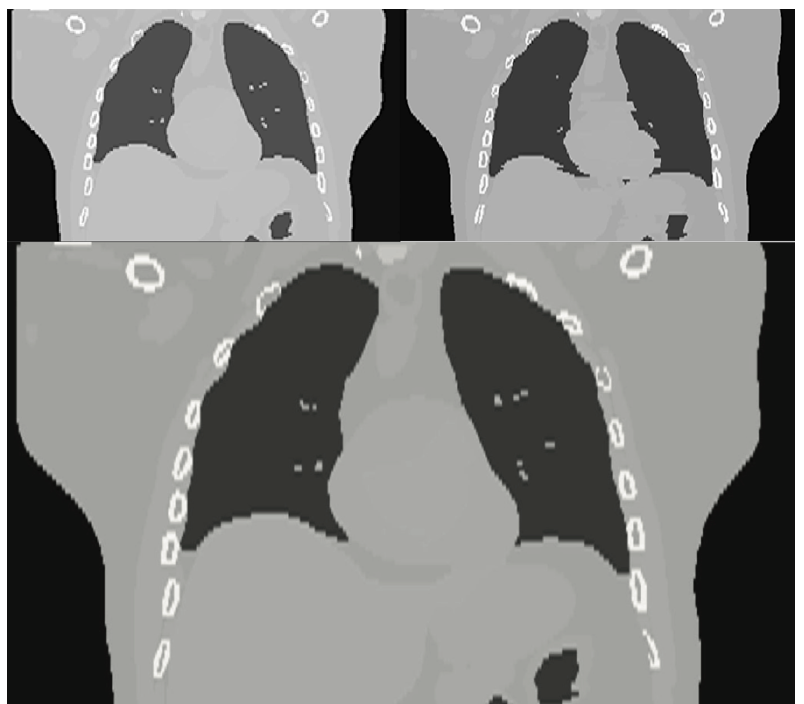
Figure 5. The XCAT phantom images based experiment results. The upper row: two CT scans with simulated motion artefacts. The bottom row shows the super-resolution CT scan.